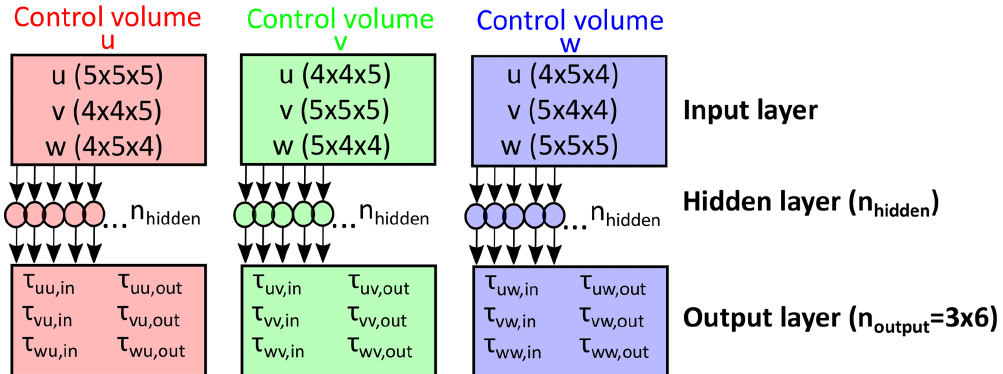
Figure 3. Architecture of ANN framework used in this study. We combined three separate ANNs that each correspond to one of the three considered control volumes. For more information, please refer to Sect. 3.3.